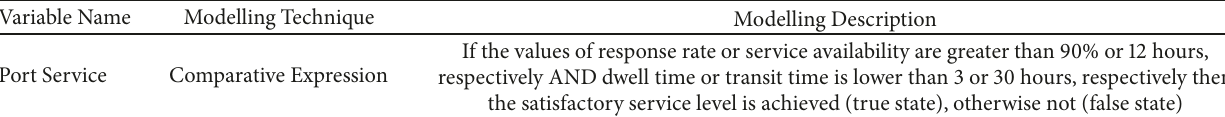
Table 8: Modelling of service variable.